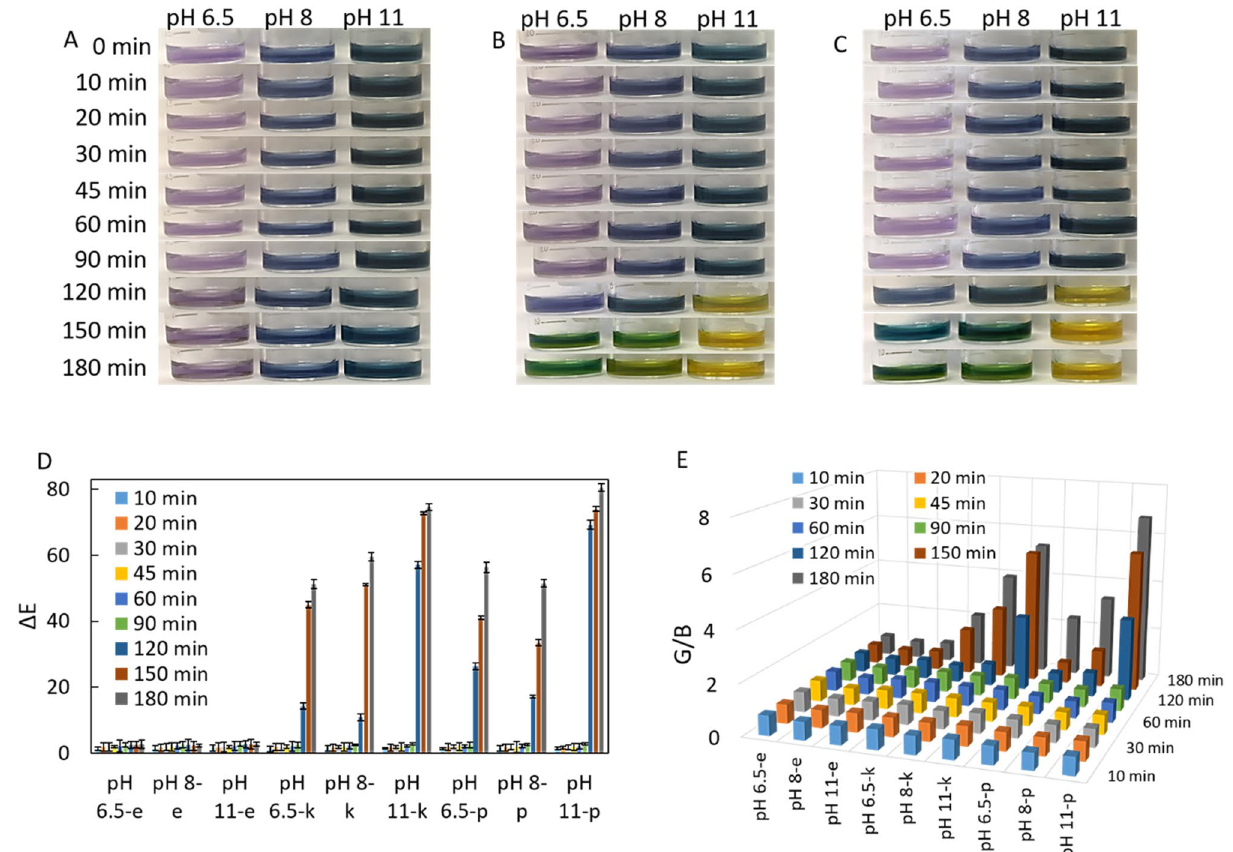
Figure 1. Colorimetric readouts of test 1, test 2 and test 3 with a naked eye for detection of 1.5 McFarland bacterial suspension of ( A ) E. coli, ( B ) K. pneumoniae and ( C ) P. mirabilis . ( D ) with ΔE values and E) G/B values. Not: pH 6.5-e, pH 8-e and pH 11-e represent presence of E. coli in the tests adjusted to those pH values; pH 6.5-k, pH 8-k and pH 11-k represent presence of . K. pneumoniae in the tests adjusted to those pH values; pH 6.5-p, pH 8-p and pH 11-p represent presence of P. mirabilis in the tests adjusted to those pH values. The error bars demonstrate one standard deviation (SD) obtained from three independent measurements (n =